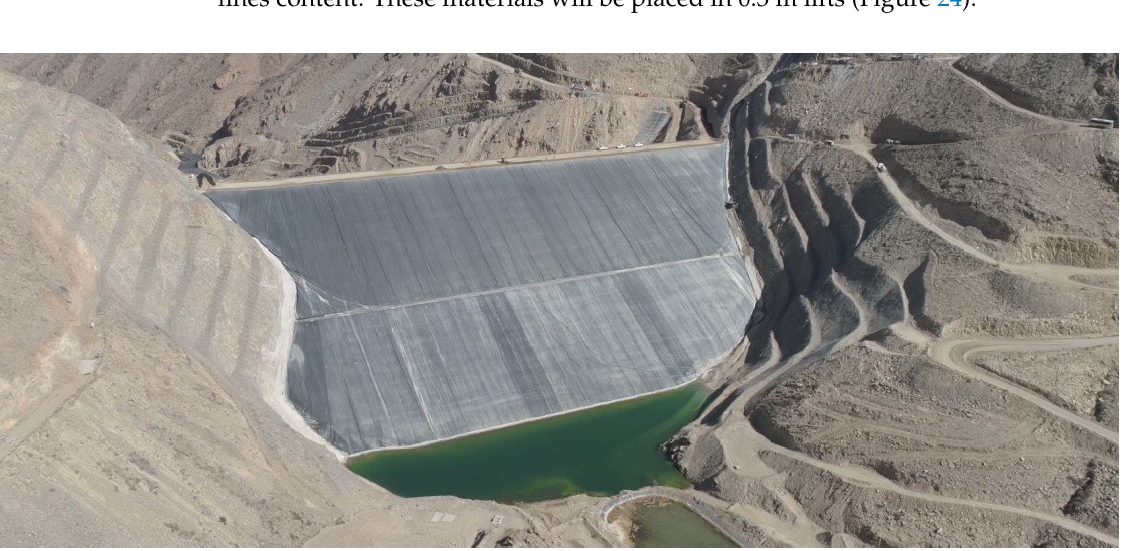
Figure 24. Front view—mine waste rock dam upstream face waterproofing construction detail—TSF, Peru.